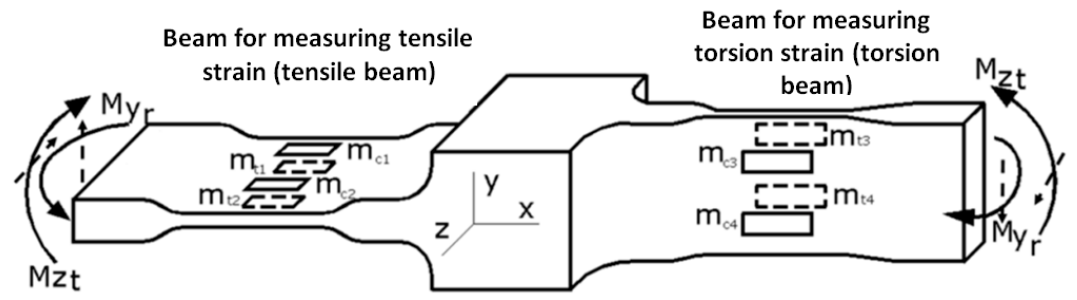
Figure 3. Configuration of the elastic beams.